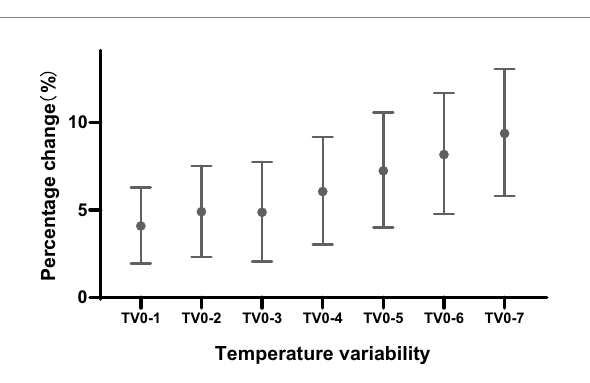
FIGURE 1 PC with 95% CI for ischemic stroke onset per 1 ° C increase in temperature variability at different exposure days. CI, confidence interval; PC, percentage